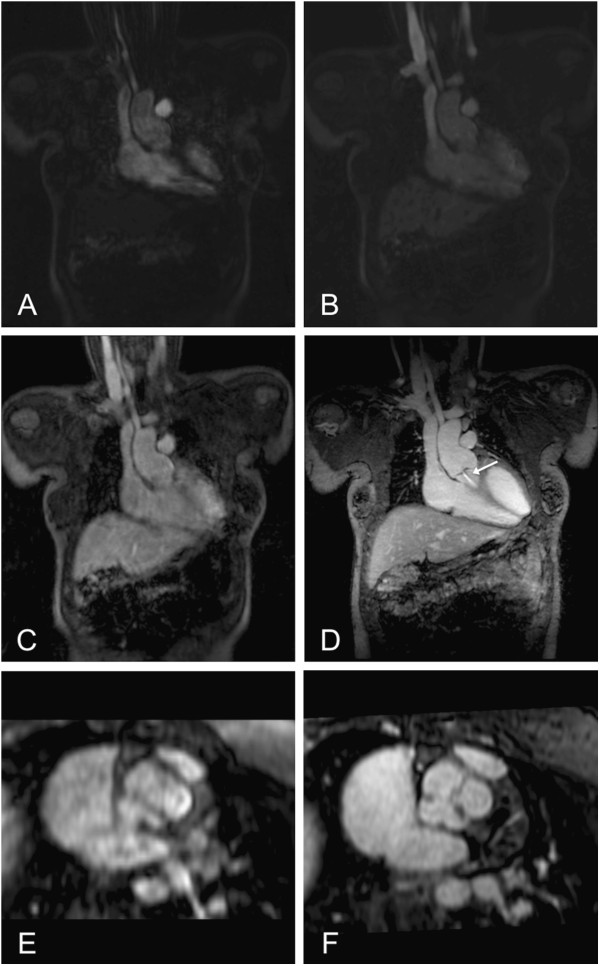
11-year-old patient after surgical correction of a common arterial trunk. FP-MRA (A-C) and HR-MRA (D) in coronal plane. Note the insufficiency jet of the aortic valve (arrow). En face view of the arterial truncal valve with three leaflets in FP- (E) and HR-MRA (F).